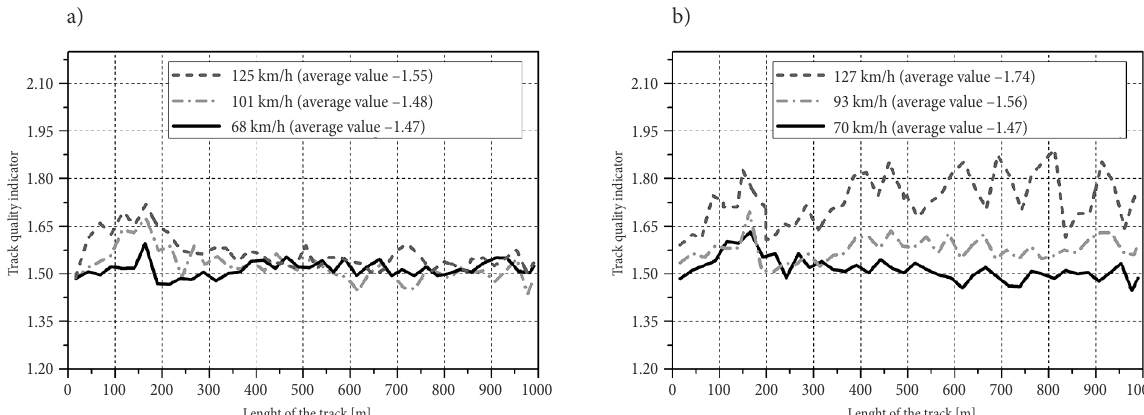
Fig. 9. Aspects of a vehicle velocity: a – the influence of velocity of railway vehicle on the TQI; b – the TQI independence of velocity of railway vehicle